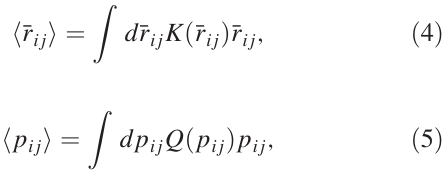
FIG. 1. Comparison of the distance matrices (DM or (upper triangle) are compared side by side. The color bar indicates the value of the mean spatial distance h R obtained by solving Eq. (3) using the contact probability P [calculated using Eq. (A1)]. The matrix size is 2000 × 2000 after the block averaging is applied to the raw data (Appendix C). The threshold value for contact is r derived from experimental data [6] over the range from 146 to 158 Mbps for chromosome 5 in the human GM12878 cell line. (b) Relative error δ is represented as a heat map. The relative error is calculated as δ ¼ ð d and simulated distances, respectively; δ increases for loci with large genomic distance indicating the tendency to overestimate the distances for loci pairs with small probabilities. (c) Ward linkage matrices (WLMs) from the simulation and theoretical predictions, shown in the lower and upper triangle, respectively, are in excellent agreement with each